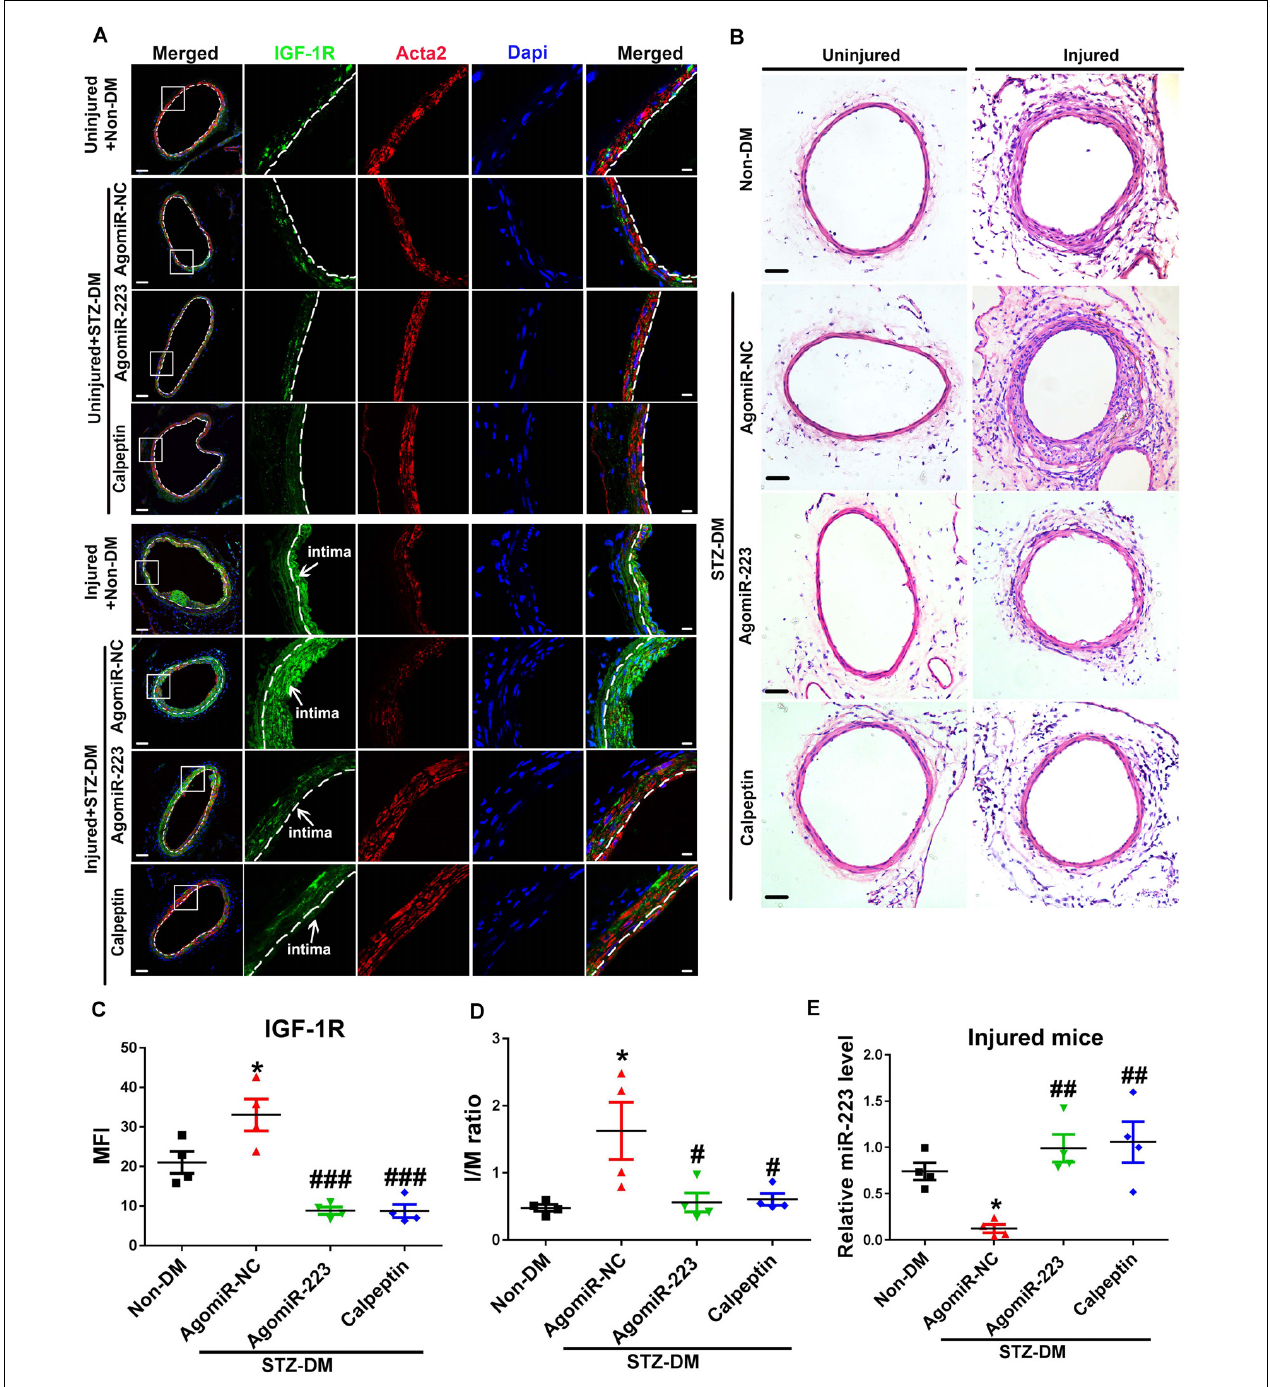
FIGURE 6 | Inhibition of calpain alleviates neointima formation by restoring the expression of miR-223 in diabetic platelet. (A) Immunofluorescence analysis of IGF-1R in uninjured or injured femoral arteries from Non-DM mice, and STZ-DM mice treated with AgomiR-NC or AgomiR-223 or calpeptin at 4 weeks after wire injury ( n = 4). Green, IGF-1R; red, Acta2 blue; Dapi nuclear staining in VSMCs. Scale bars: 20 µ m. (B) H&E staining of serial cross sections of femoral arteries from Non-DM mice, and STZ-DM mice treated with AgomiR-NC or AgomiR-223 or calpeptin at 4 weeks after wire injury ( n = 4). Scale bars: 50 µ m. (C) Quantification of IGF-1R expression in VSMCs in injured DM mice. (D) The intima size (I/M ration) in the injured femoral arterial sections has been quantified. (E) The miR-223 level in injured DM mice was detected by qRT-PCR assays. Data are presented as mean ± SD ( n = 4). Comparisons between more than two groups were analyzed using one-way ANOVA analysis with the Dunnett’s multiple correction. * P < 0.05 vs non-DM; # P < 0.05, ## P < 0.01, ### P < 0.001 vs STZ-DM mice treated with AgomiR-NC.